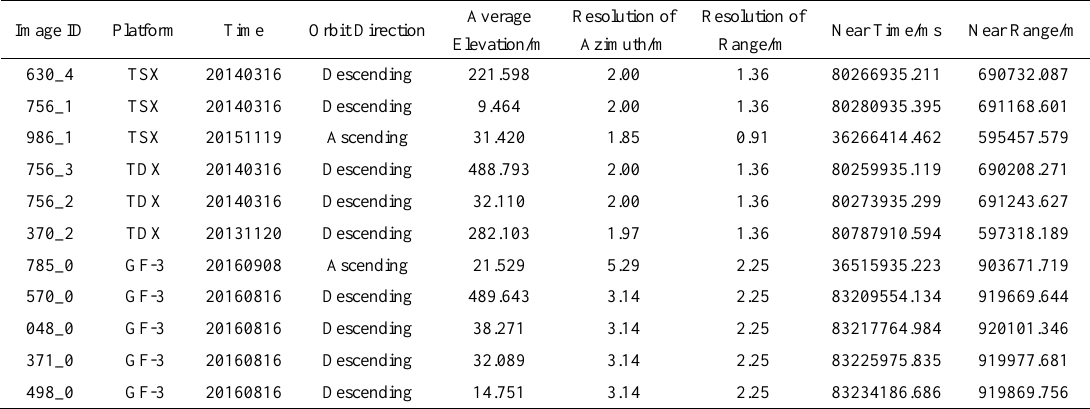
Table 1. Basic parameters of study images